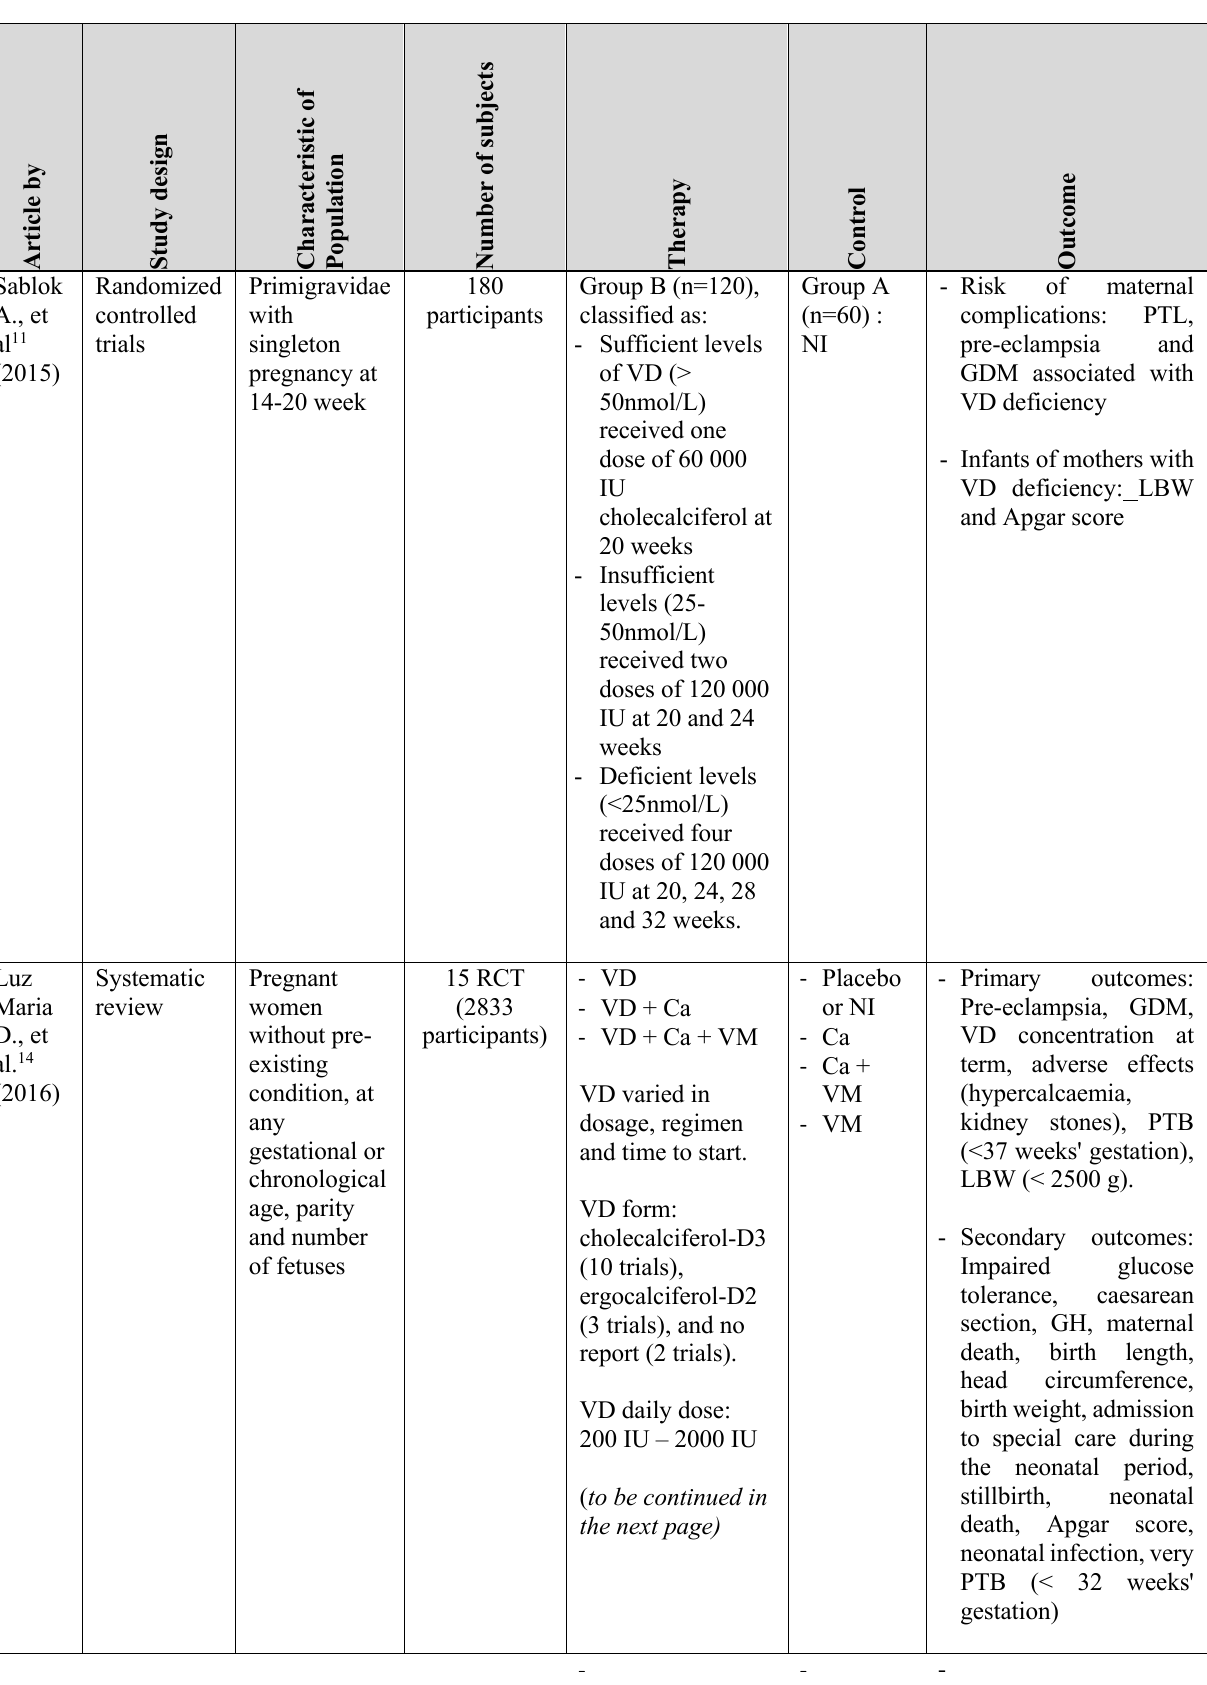
Table 2 . Characteristics of